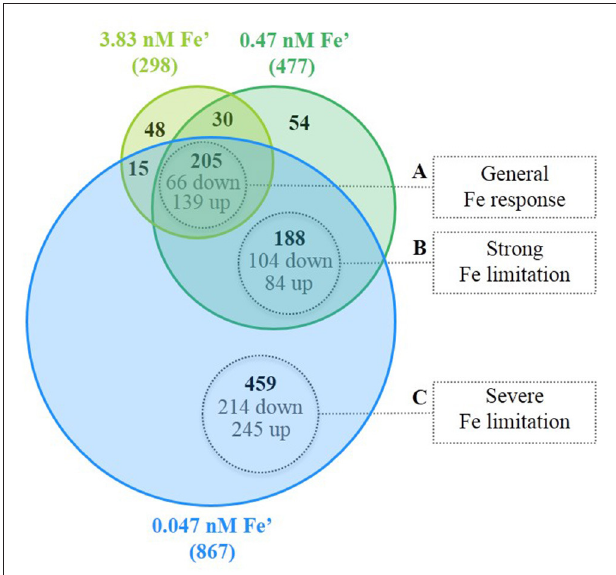
FIGURE 4 | Differentially expressed genes (DEG) in response to iron (Fe) limitation. Venn diagram represents the amount of DEG for the different treatments with Fe limitation in relation to the Fe replete condition (bold values). Values in gray indicate the amount of genes significantly up- and